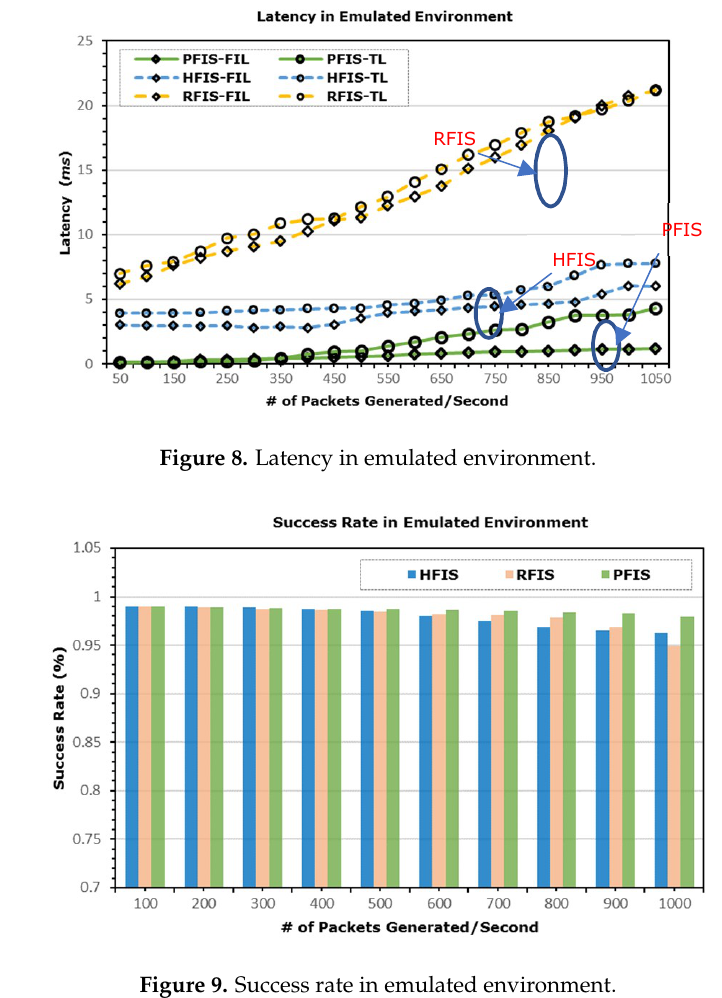
Figure 9. Success rate in emulated environment.